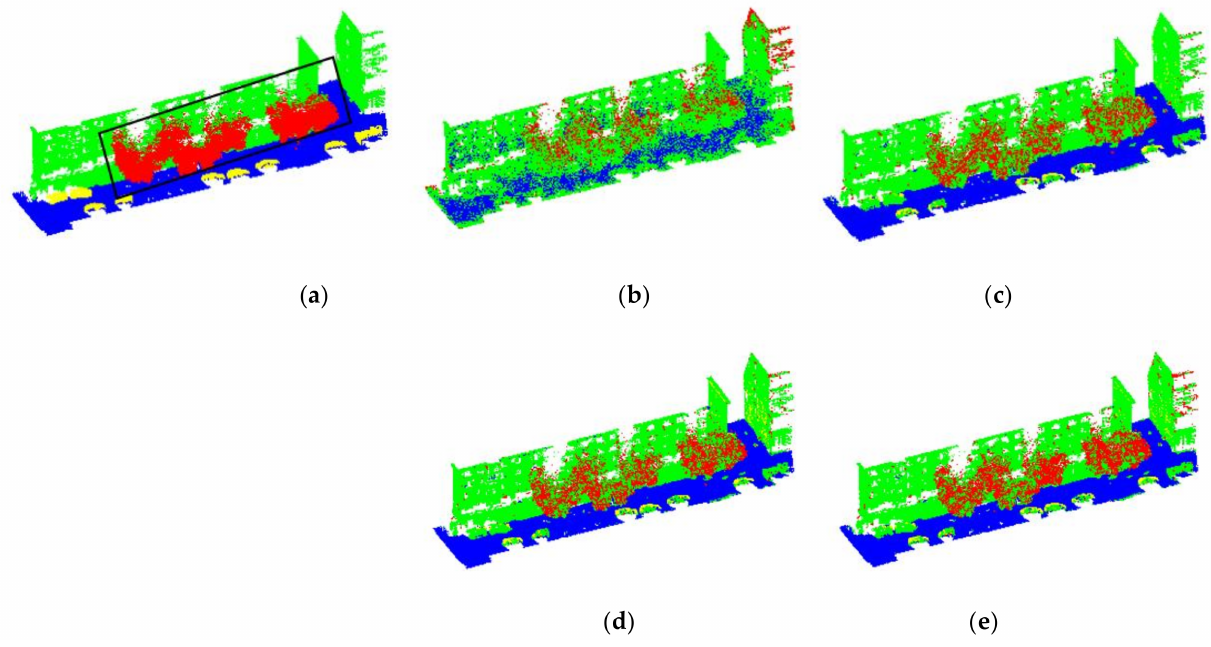
Figure 11. Classification results for Scene 3. ( a ) Ground truth; ( b ) Method 1; ( c ) Method 2; ( d ) Method 3; and ( e ) our method. Red, green, blue, and yellow points represent trees, buildings, floors, and cars,